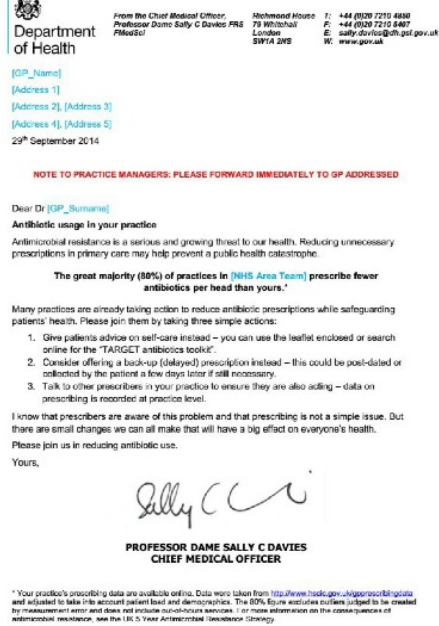
Figure 1. Example of the first GP feedback letter sent to GP Practices in 2014.